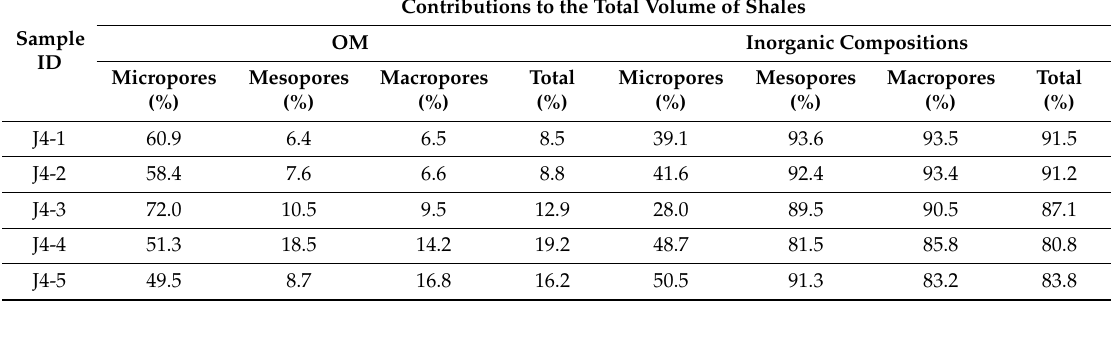
Table 5. Contributions of OM and inorganic minerals to the total pore volume of the W-L shales.